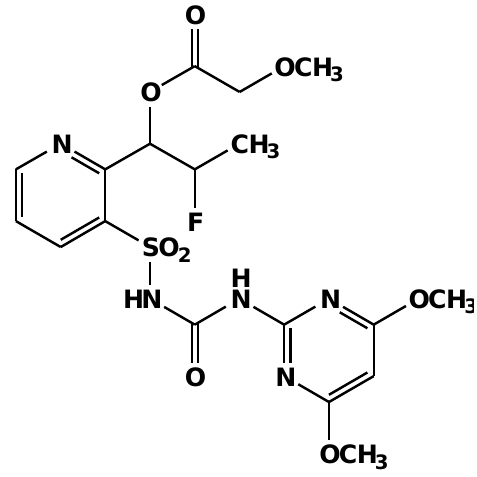
Figure 1. Structure of flucetosulfuron.